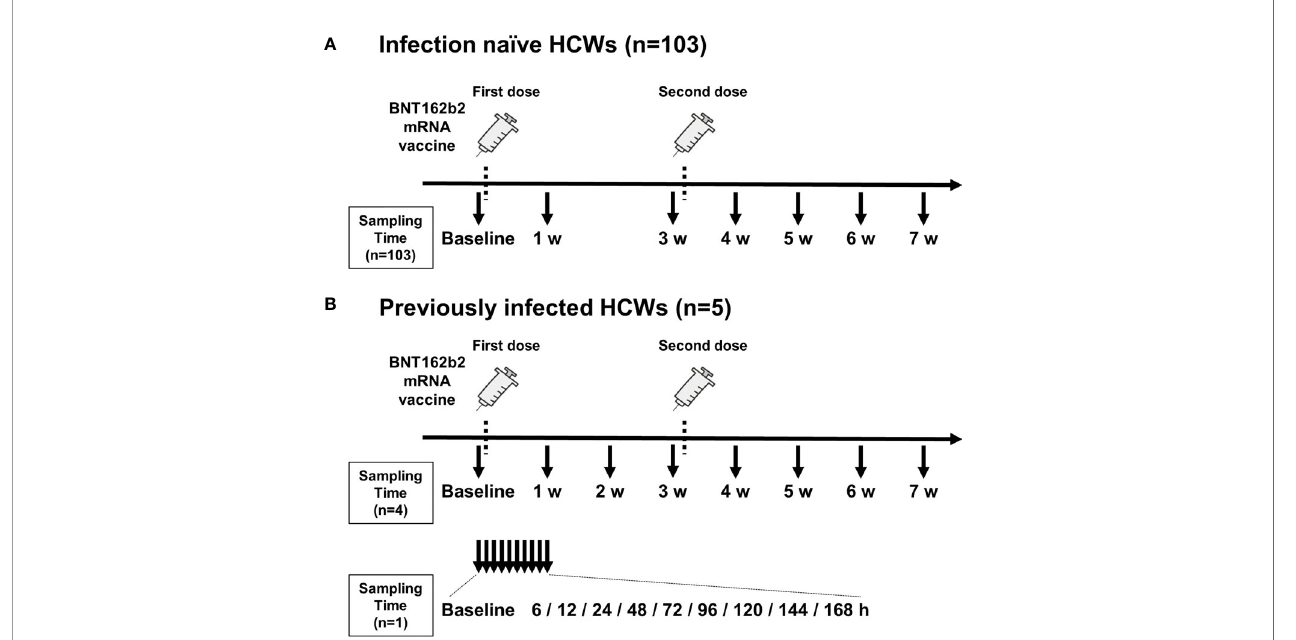
FIGURE 1 | Timing of vaccination and blood sample collection. (A) Timing of blood sampling from 103 infection-naïve health care workers (HCWs). (B) Timing of blood sampling from fi ve previously infected HCWs. Blood was sampled from four HCWs on a weekly basis (top) and from one HCW on an hourly basis (bottom). The timing of administration of two doses of BNT162b2 mRNA vaccine is indicated by dotted lines. Arrows indicate the timing of blood collection. Blood samples were collected before the fi rst vaccination (baseline) and just before the second vaccination (3 w). w, week; h,